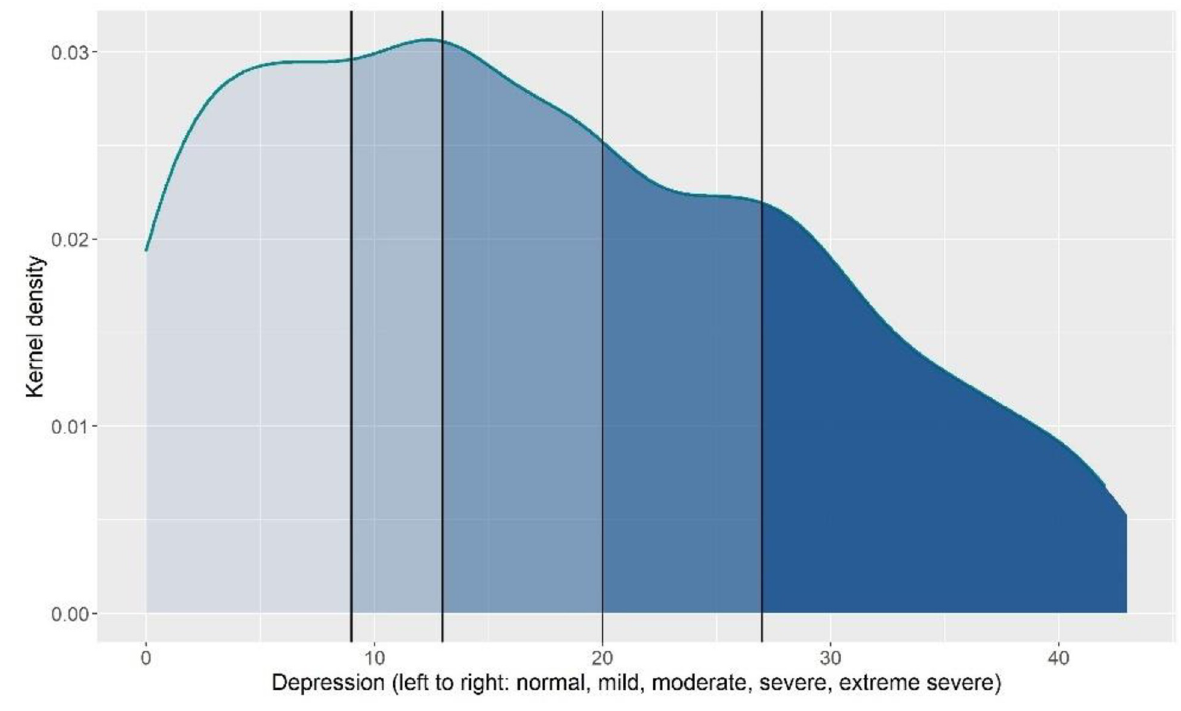
Fig 2. Distribution of